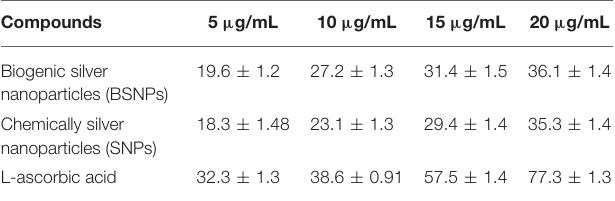
Frontiers in Chemistry |